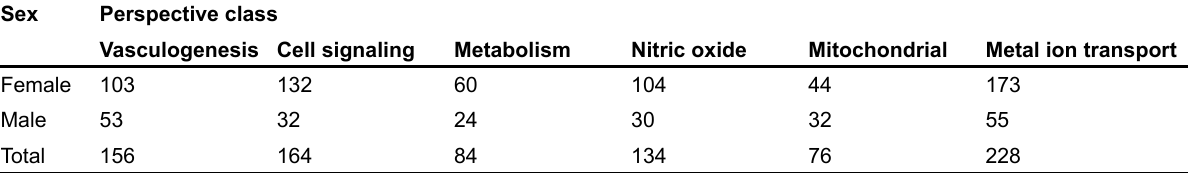
Table 2. Sex-based differences in perspective classes of AD progression Sex Perspective class Vasculogenesis Cell signaling